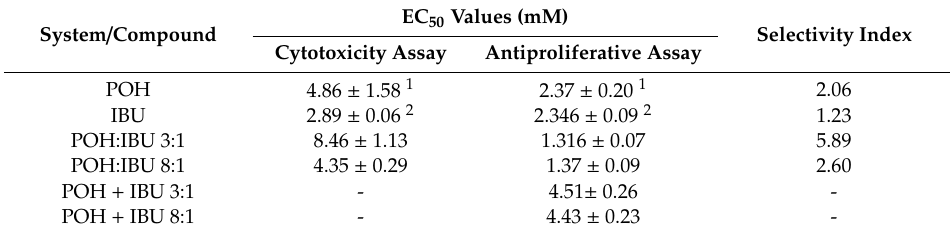
Table 5. EC 50 values for the cytotoxicity and antiproliferative assays, and obtained selectivity index, for the selected THEDES, individual compounds and physical mixtures. Results were obtained from three independent experiments performed in triplicate.